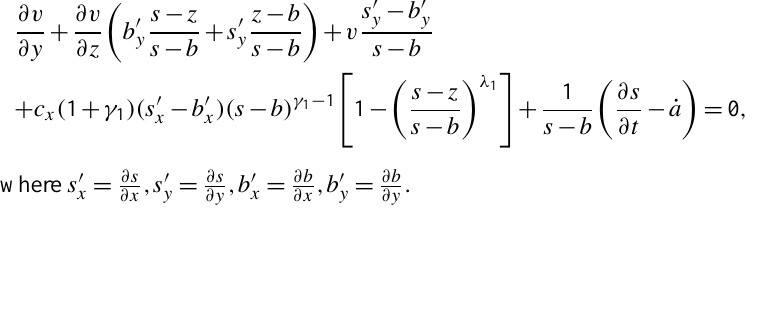
s − z z − b + ∂s = h ∂d generates a first-order quasi-linear partial ∂y s − b ∂y s − b ∂x